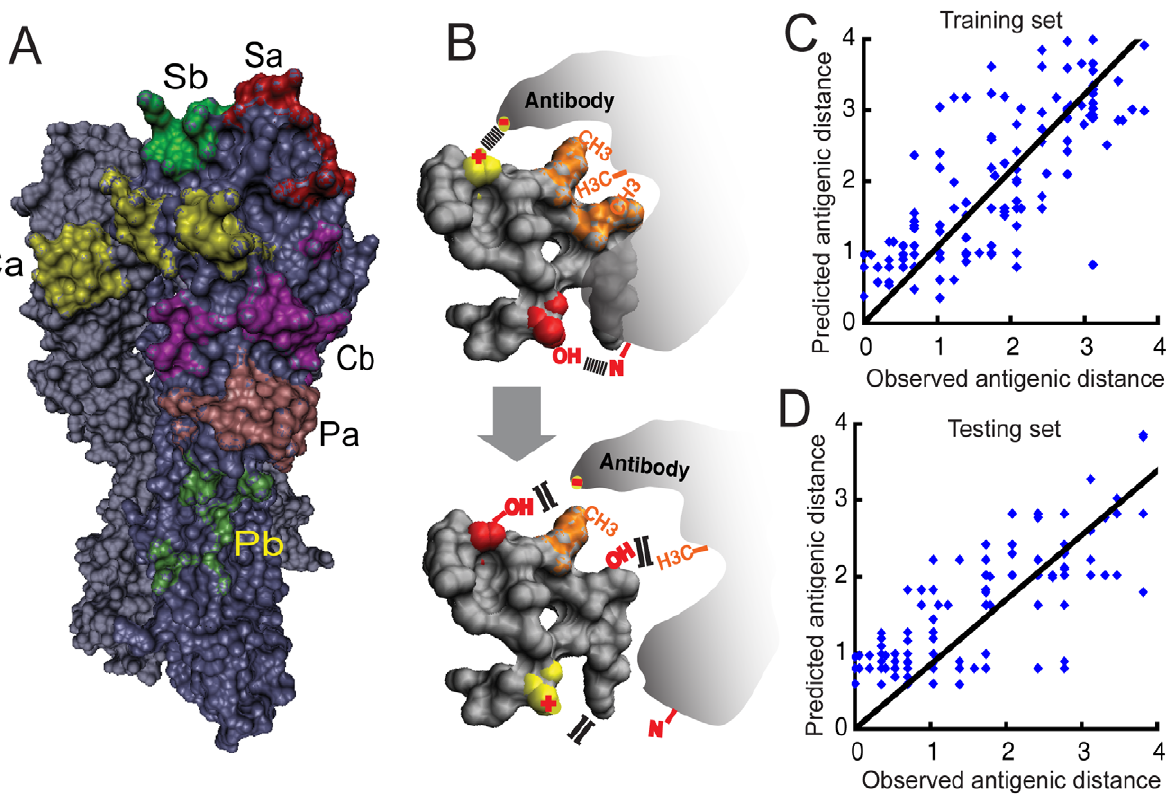
Figure 3. The epitope-based antigenic distance prediction (EADpred) model and its performance. (A) Six derived antigenic epitopes (Sa, Sb, Ca, Cb, Pa and Pb) on human influenza A(H1N1) HA protein were considered as the structural basis underlying the interactions between HA and neutralizing antibodies. They were marked on the surface of the structure model of HA of A/putertorico/8/34 (H1N1) virus (PDB ID: 1RVZ) using different colors. (B) A cartoon illustrating the physicochemical mechanisms underlying an epitope-mediated interaction between HA and antibody. Salt-bridge interaction was shown by a link between two charged atoms. Hydrogen bonding was represented as a link of ‘‘-OH—N-’’. Hydrophobic microenvironment was described as a cluster of hydrophobic groups highlighted in orange. (C–D) The prediction performances on the training data (C) and testing data (D). Black lines reflect linear fit with a zero intercept. The linear fits to the training data and testing data yield correlation coefficients of 0.79 and 0.80 respectively. The details for the model description see the Materials and